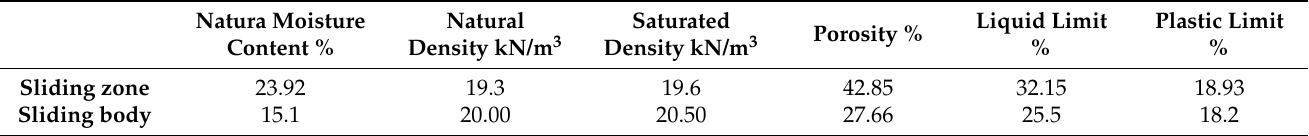
Table 2. Physical properties of the natural sliding zone and sliding body soil samples.